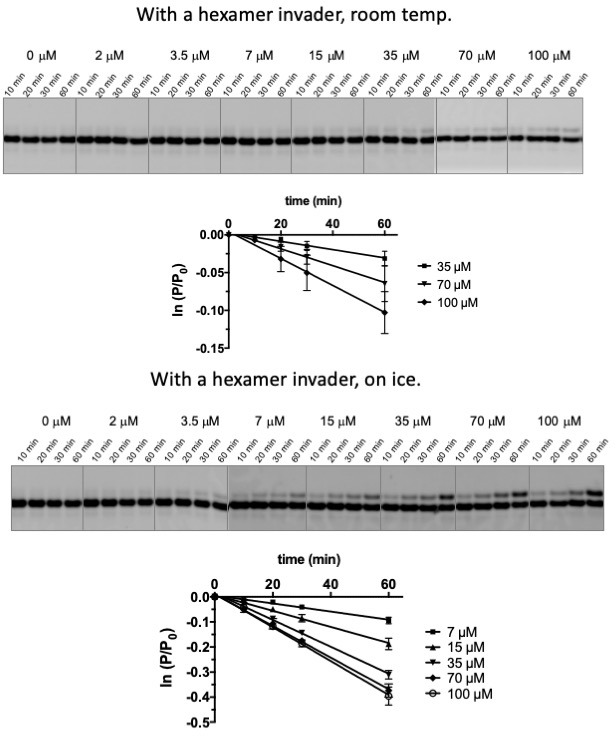
Representative denaturing PAGE data and plots of ln(P/P0) vs. time for the reaction kinetics with a hexamer invader as described in Figure 2.